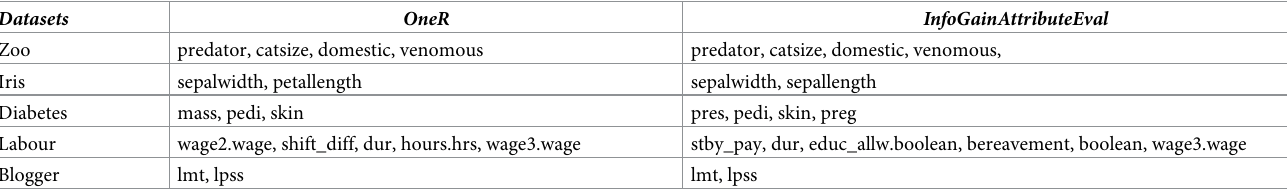
Table 3. Attributes removed by OneR and InfoGainAttributeEval attribute evaluators.